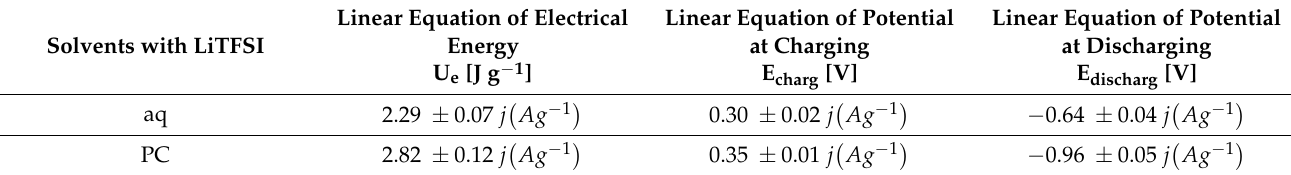
Table 1. Linear equation comparing the slopes of electrical energy U e , potential at charging E charg and discharging E discharg of PIL films in aq (aqueous) and PC (propylene carbonate) based electrolytes, with the same concentration of LiTFSI salt. Solvents with LiTFSI